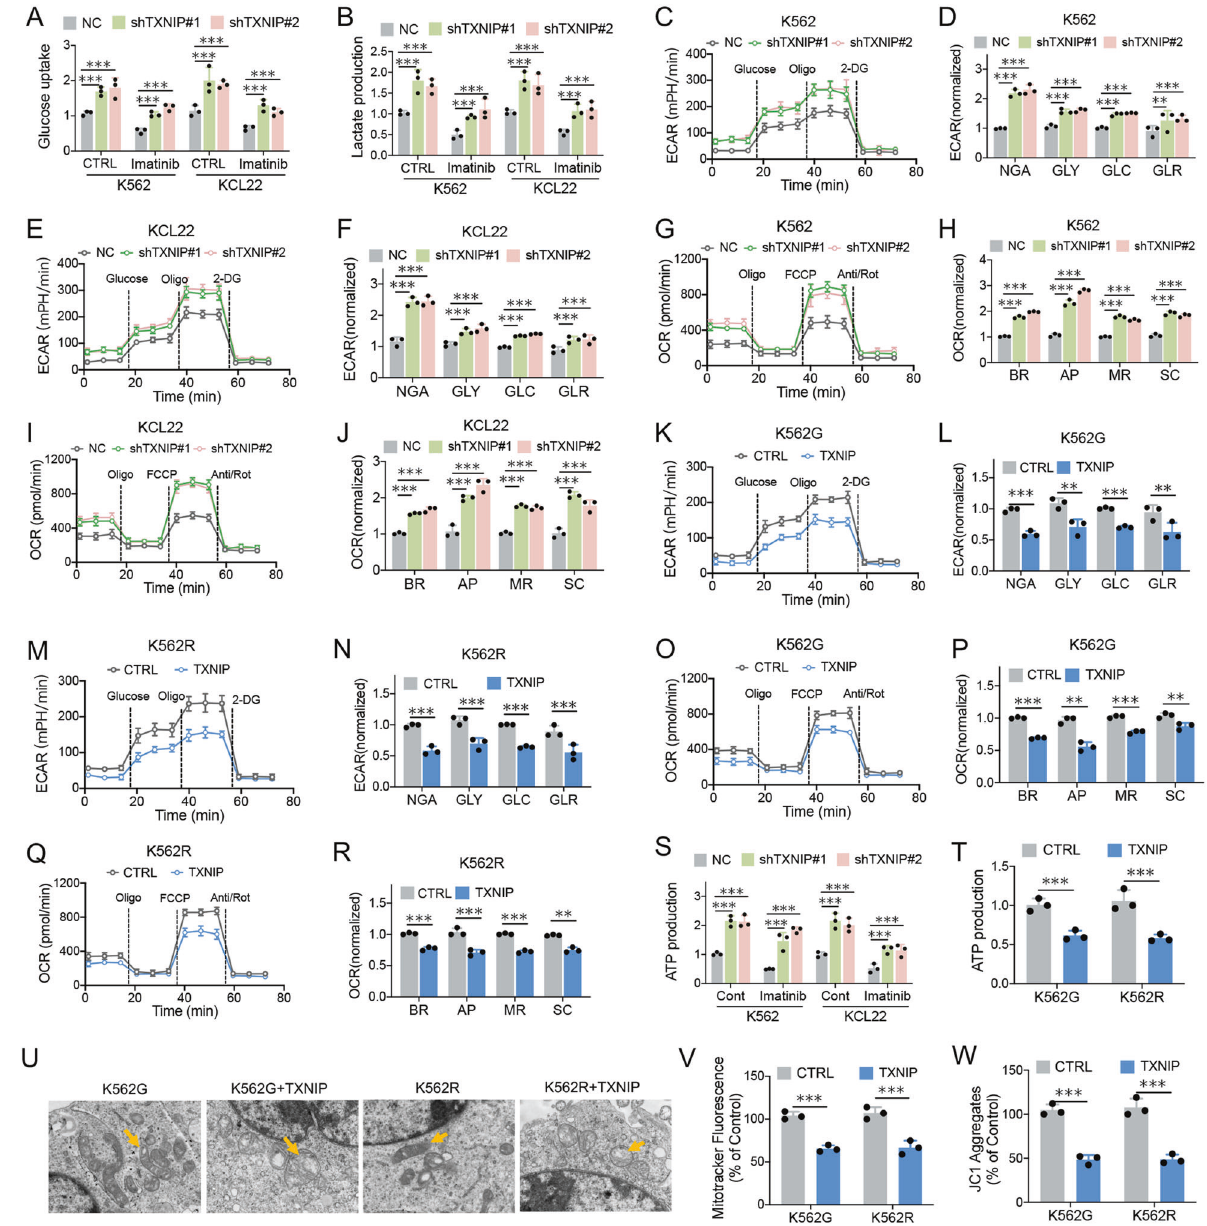
Fig. 5 BCR-ABL triggers a glucose-dependent survival program via TXNIP suppression. A 2 NBDG assays for glucose uptake in K562 and KCL22 cells with TXNIP knockdown 24 h after 1 μ M imatinib treatment. B Lactate production in K562 and KCL22 cells with TXNIP knockdown 24 h after 1 μ M imatinib treatment. C – F The high throughput Seahorse assays to monitor extracellular acidi fi cation rate (ECAR) in K562 ( C , D ) and KCL22 ( E , F ) cells with TXNIP knockdown. G – J The high throughput Seahorse assays to monitor cellular oxygen consumption rate (OCR) in K562 ( G , H ) and KCL22 ( I , J ) cells with TXNIP knockdown. K – N The high throughput Seahorse assays to monitor ECAR in K562G ( K , L ) and K562R ( M , N ) cells with TXNIP overexpression. O – R The high throughput Seahorse assays to monitor cellular OCR in K562G ( O , P ) and K562R ( Q , R ) cells with TXNIP overexpression. S , T The intracellular ATP concentrations were determined in indicated cells with TXNIP knockdown after 1 μ M imatinib treatment ( S ), or TXNIP overexpression ( T ). U The transmission electron microscope assays for assessing the mitochondrial shape in K562G and K562R cells after TXNIP overexpression. V MitoTracker-based fl ow cytometry assays for assessing mitochondrial number. W JC1-mitochondrial membrane potential assays. BR basic respiration, AP ATP production, MR maximal respiration, SC spare capacity, NGA non-glycolytic acidi fi cation, GLY glycolysis, GLC glycolytic capacity, GLR glycolytic reserve. *** P < 0.001. ** P < 0.01. drugs in vitro. JQ1 sensitized mouse cells to imatinib-induced weight loss was detected with tenovin-6 alone or in combina- apoptosis and further suppressed CFC formation (Fig. 7N, O). tion with imatinib (Supplementary Fig. 4). Imatinib extended These results indicate that JQ1 enhances imatinib treatment the survival of CML mice in a manner similar to JQ1, whereas potentially through the induction of TXNIP which results in the JQ1 plus imatinib treatment provided a further survival blockage of glucose metabolism during CML disease advantage for CML mice (Fig. 7L). Further, BM cells from CML development. mice were isolated and analyzed for their sensitivity to both